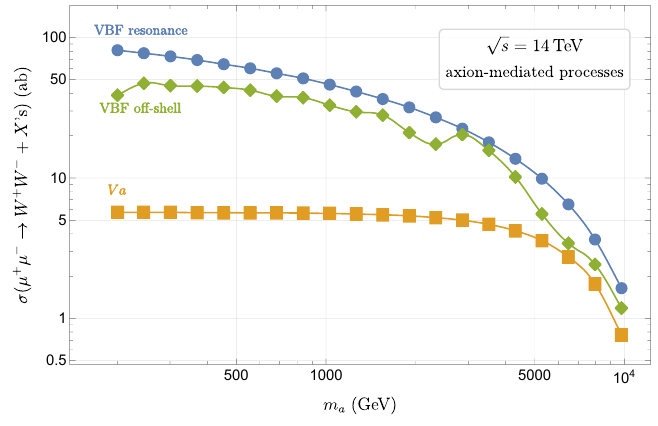
Figure 5 . Benchmark production rates of the W + W − final state via the heavy axion as a function √ of its mass at a future muon collider with s = 14 TeV. The V a channel includes both γa and Za processes with a → W + W − decay. The indirect effect of an off-shell exchange of an axion is estimated by σ off-shell ≡ σ ( µ + µ − → W + W − + X ’s ) | off-shell +SM − σ ( µ + µ − → W + W − + X ’s ) | SM , in which the σ ( µ + µ − → W + W − + X ’s ) | SM is the SM VBS cross section, and σ ( µ + µ − → W + W − + X ’s ) | off-shell +SM is the cross section of the same process including t -channel and off-shell s -channel ALP diagrams. Similarly, the corresponding VBF resonance cross section is also for W + W − final state. Note that the fluctuation of σ off-shell ( m a ) lies within the Monte Carlo uncertainties and is likely due to numerical